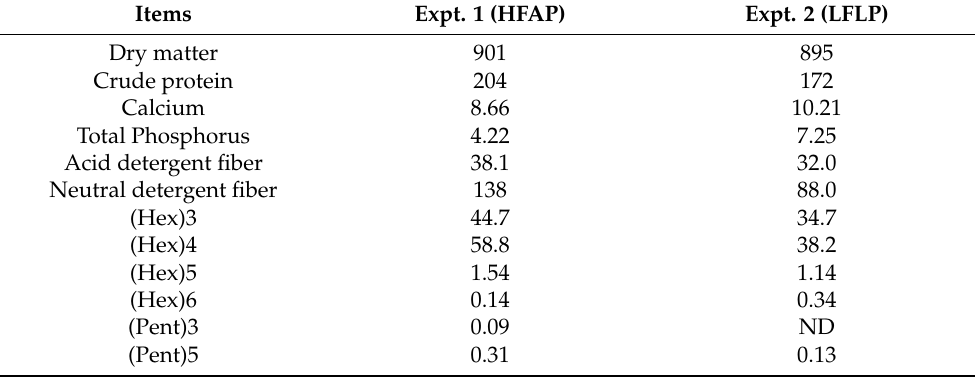
Table 2. Analyzed composition (g/kg) of experimental